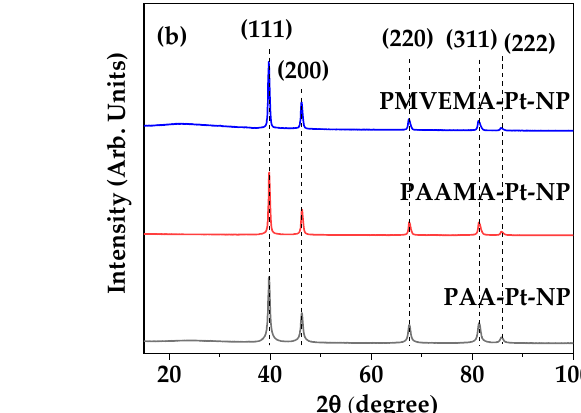
Figure 3. ( a ) Photographs of the diluted NP solution samples, showing no NP precipitation after synthesis for >1.5 years. ( b ) Zeta potential curves of the diluted NP solution samples and Gaussian function fits to obtain ζ avg . ( c ) Laser light scattering (indicated with dotted arrows) due to laser light collision with NP colloids in aqueous media, showing good colloidal dispersions, whereas no laser light scattering was observed for the vial containing triple-distilled water.